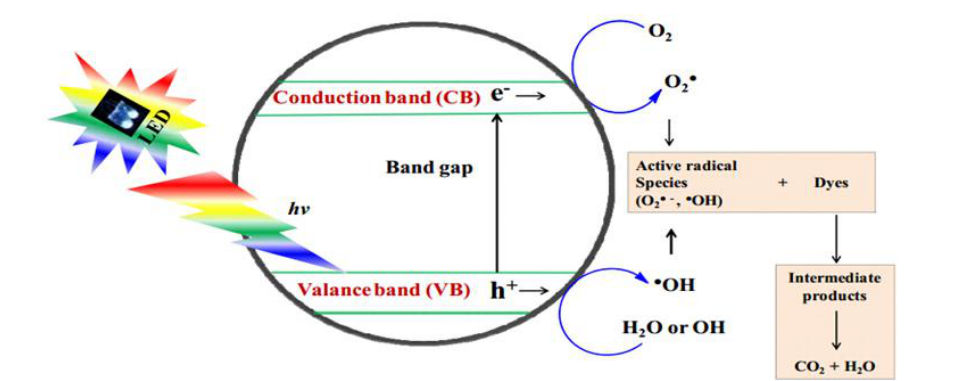
Fig. 1: The mechanism of photocatalysis